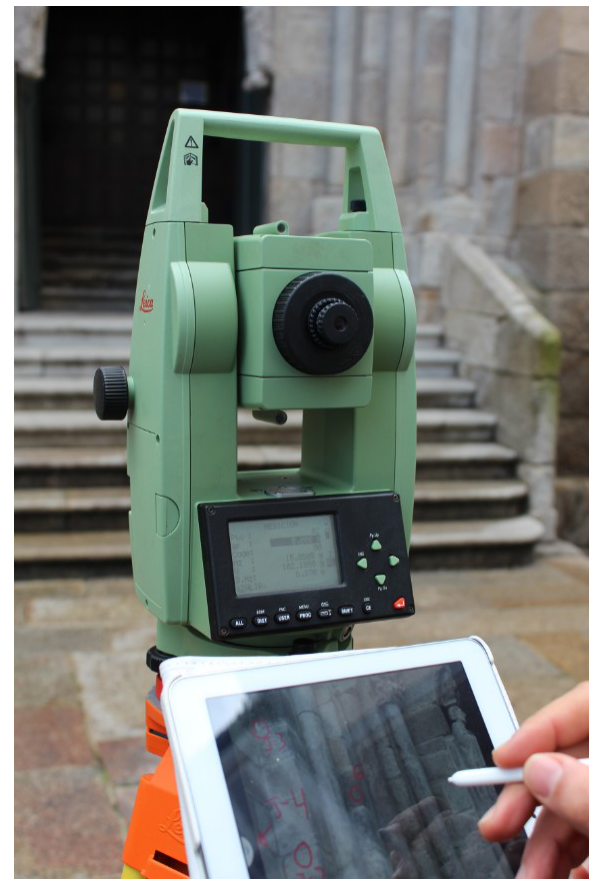
Figure 6. Point measurements collected on site with laser total station aided with a mobile device.